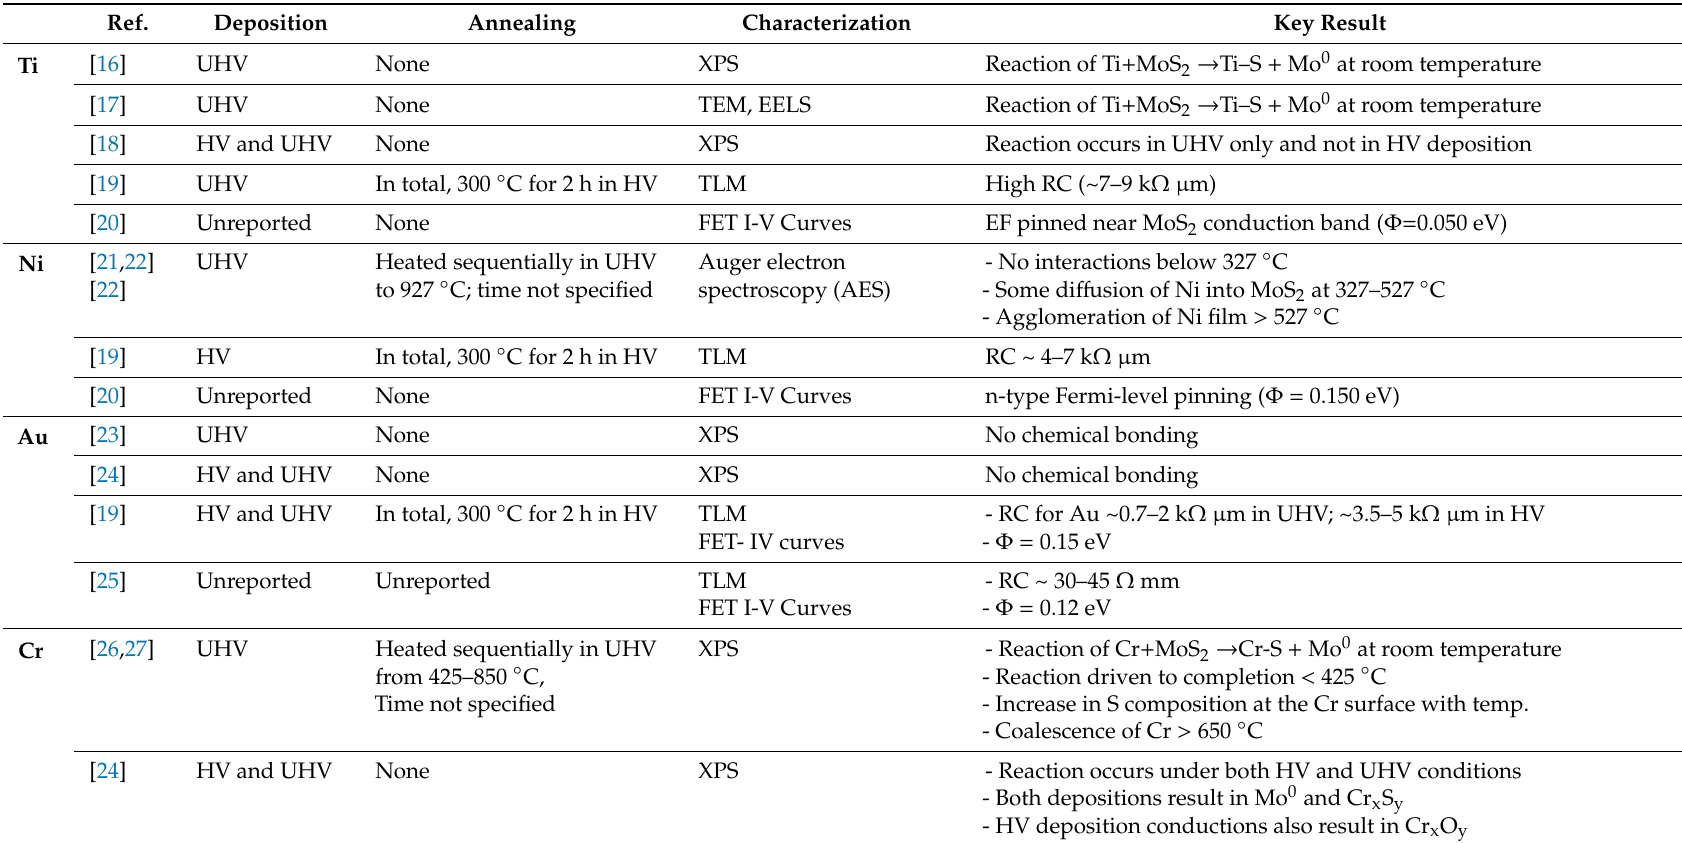
Table 1. Summary of literature on experimental chemical and electronic characterization of metal–MoS 2